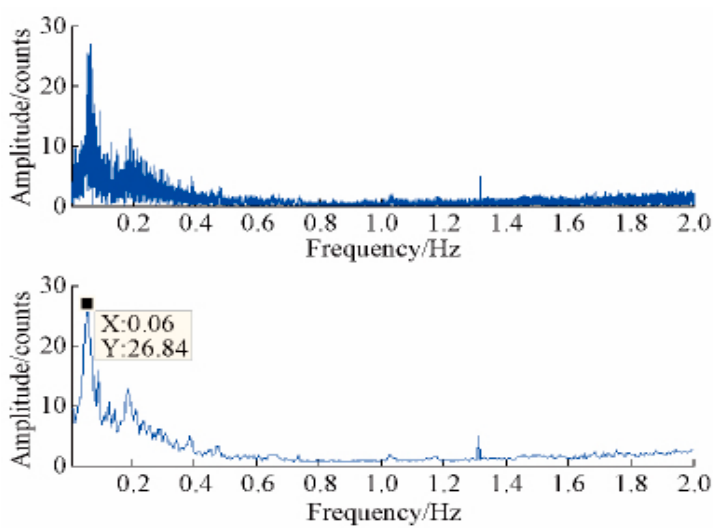
Figure 3. Spectrum envelope of Wuhai (WUH) station at 5:00 on 6 April 2015.